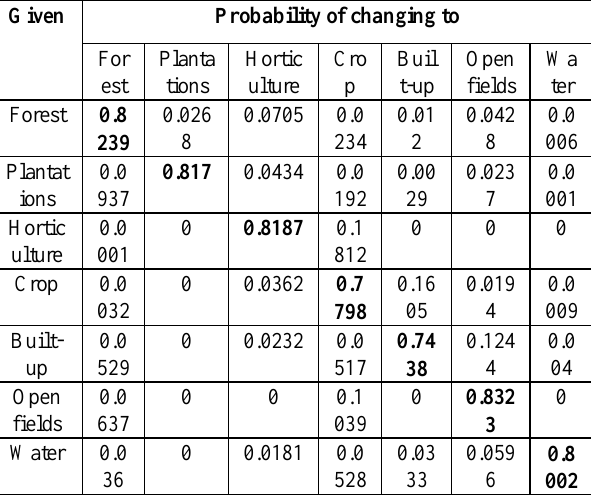
Table 4(b). Transition probability matrix for